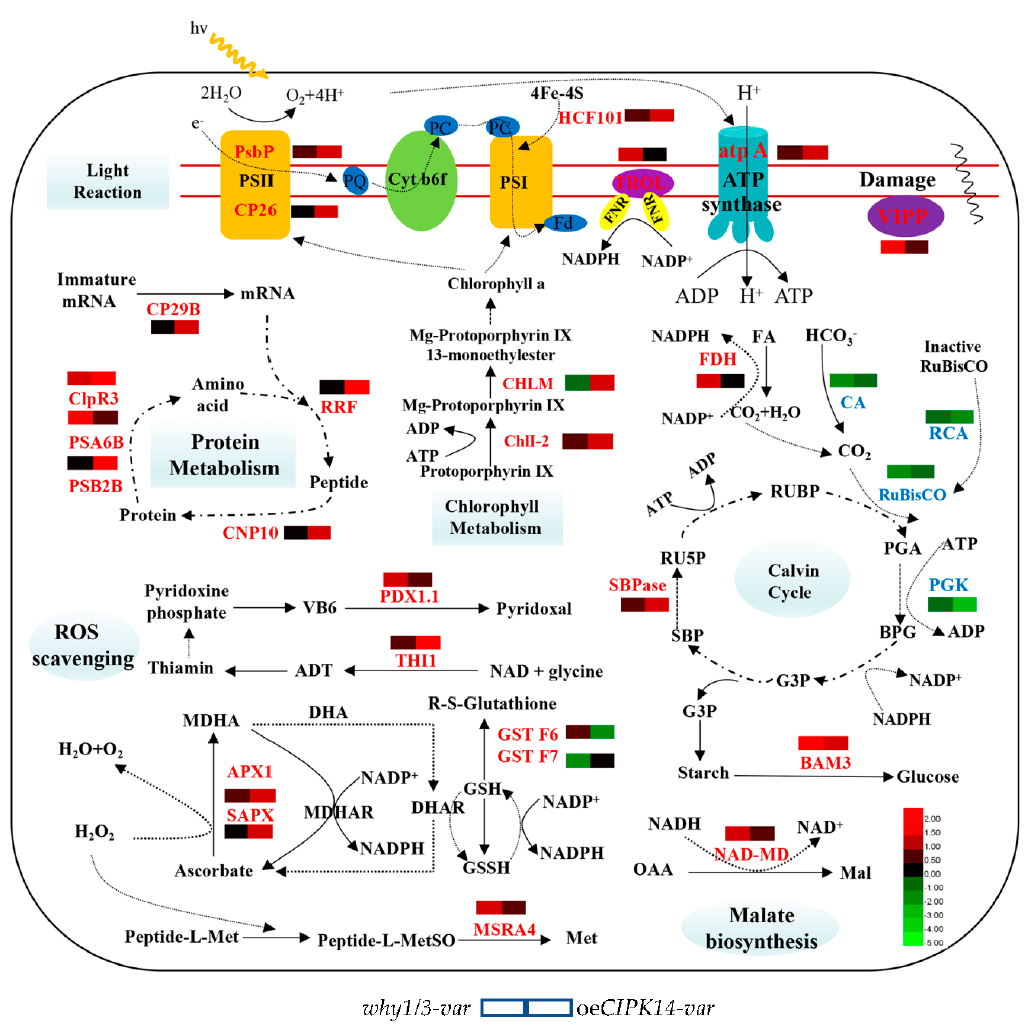
Figure 7. Summary of CIPK14 or/and WHIRLY1/3 mediated pathways in chloroplasts, including light reaction, chlorophyll metabolism, ROS scavenging, malate biosynthesis, calvin cycle, and protein metabolism. The solid lines indicate a direct pathway, the dashed lines indicate a hypothetic connection.